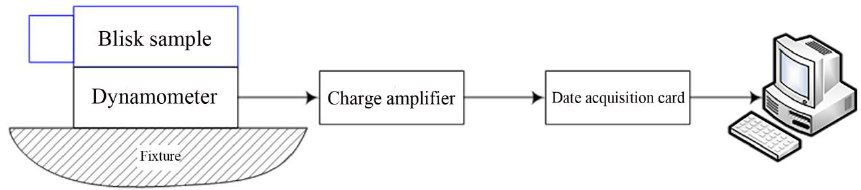
Figure 13. Installation diagram of a force-measuring system.